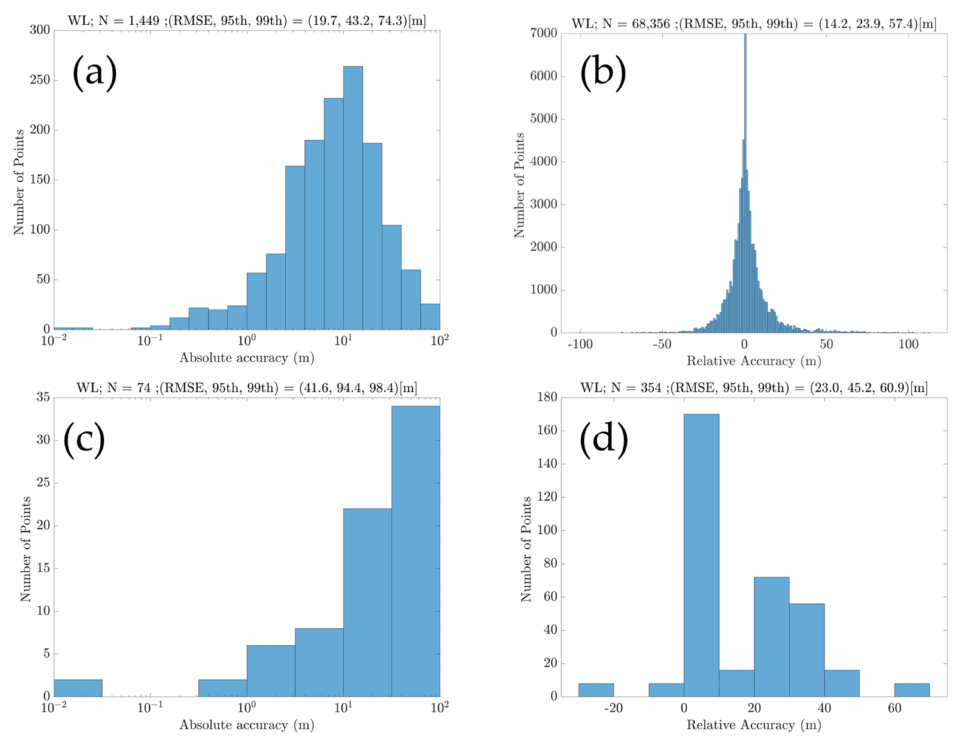
Figure A1. Results of the quantitative accuracy absolute and relative assessment at Site #3 ( a , b ) for waterline extracted from sentinel-2 MSI taken 2 October 2019 at 11:21 UTC and at Site #1 & #2 ( c , d ) for waterline extracted from sentinel-2 MSI taken 25 June